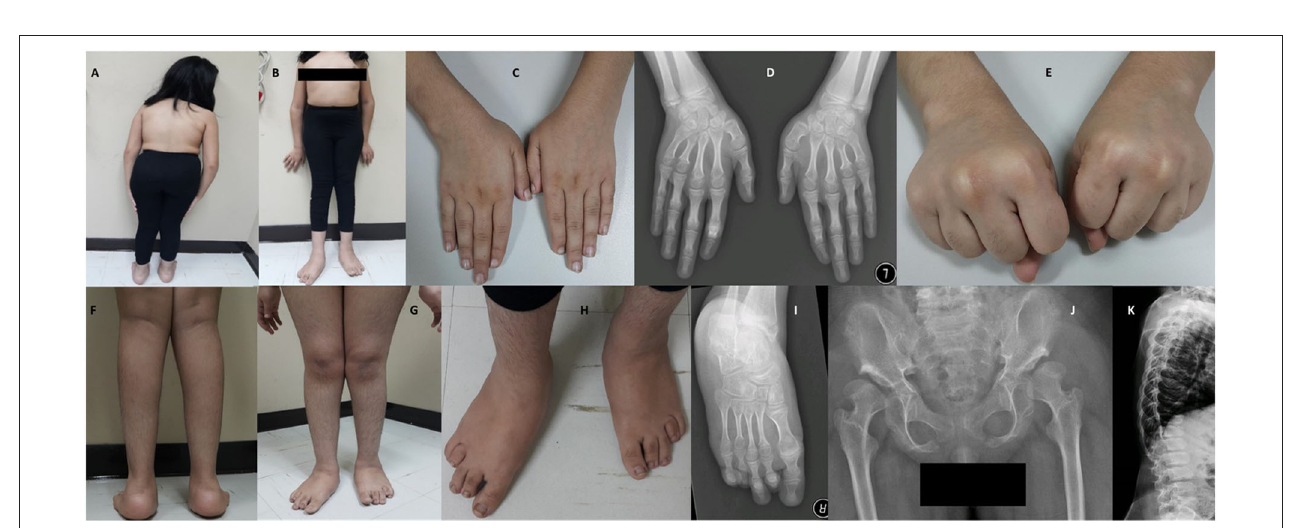
FIGURE 1 | Pedigree of the DMC family in which homozygous insertion variant (c.95_96insT, p.W33Lfs*14) segregates. Available samples are labeled with asterisks, and double lines show consanguineous unions. The red-colored genotype represents the disease allele. The numbers in the symbols show the unaffected male and female siblings of IV-7.